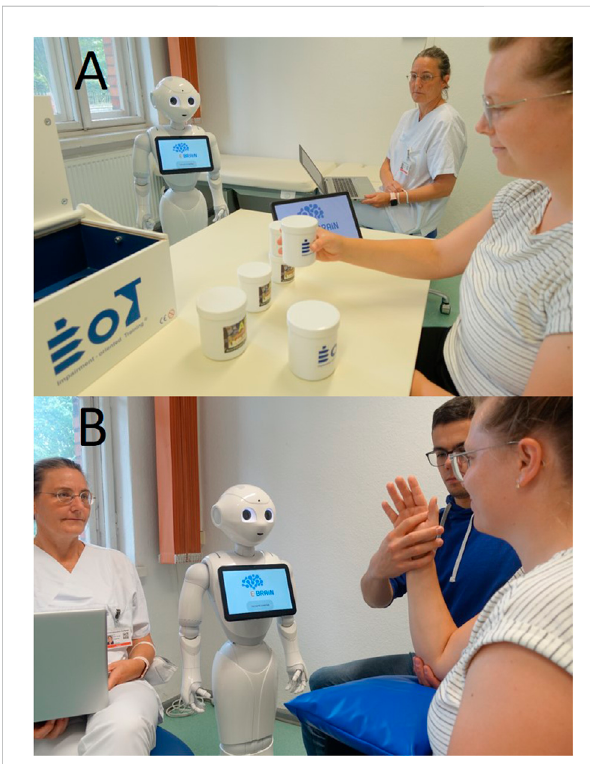
FIGURE 2 The therapeutic scenarios for the digital therapeutic system E-BRAiN using a humanoid robot to provide therapeutic interaction duringarmrehabilitationsessions[i.e.,AATformildarmparesis (A) and ABT for moderate-to-severe arm paresis (B) ] for stroke survivors. It should be noted in the scenario for the AAT (A), the patient is able to train the (mildly) affected right arm self-suf fi ciently; here, the robot provides all therapeutic interactions (information provision, feedback, and bond-related interaction) while the patient is led through a sequence of training tasks; the supervising staff in the background is only monitoring the situation and ready to step in in case the system designed to run autonomously showed an error or a patient ’ s need could not be met by the system. The situation for the ABT is similar with regard to the role of the humanoid robot and supervising